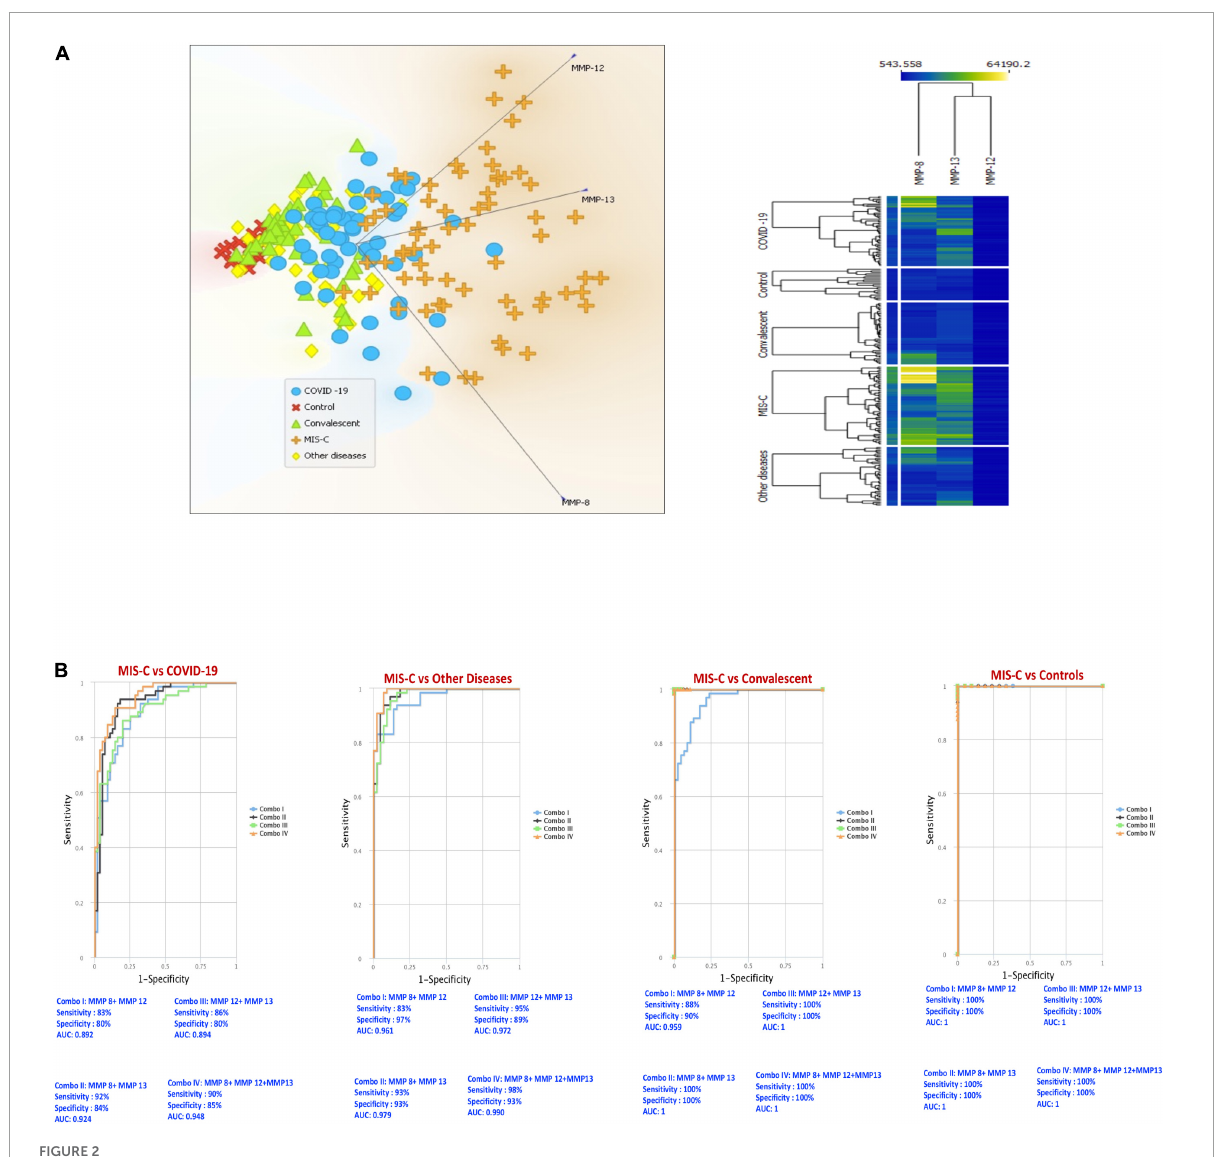
FIGURE2 PCA and ROC reveals the trend of matrix metalloproteinases (MMPs) among multisystem inflammatory syndrome in children (MIS-C), COVID-19 and other groups. (A) Principal component analysis (PCA) was performed to show the distribution of data from the combination of five groups: MIS-C (brown), acute COVID-19 (blue), children with other diseases (yellow color), convalescent COVID-19 (green) and control (red) children depicted using normalized data from plasma levels of MMP-8, 12 and 13. (B) CombiROC analysis was performed to determine the role of MMP 8, 12 and 13 in distinguishing between MIS-C vs. acute COVID-19, MIS-C vs. other diseases, MIS-C vs. convalescent and MIS-C vs.